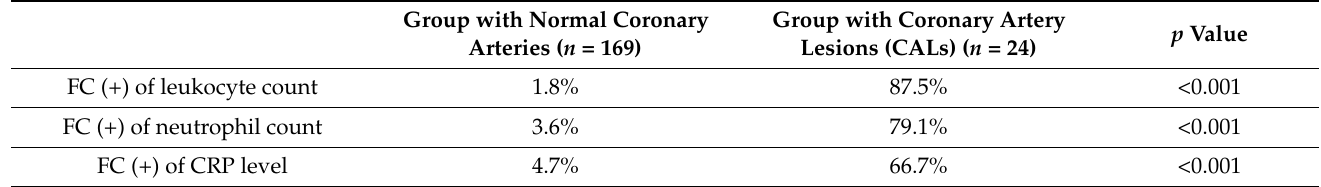
Table 4. Effectiveness of fractional